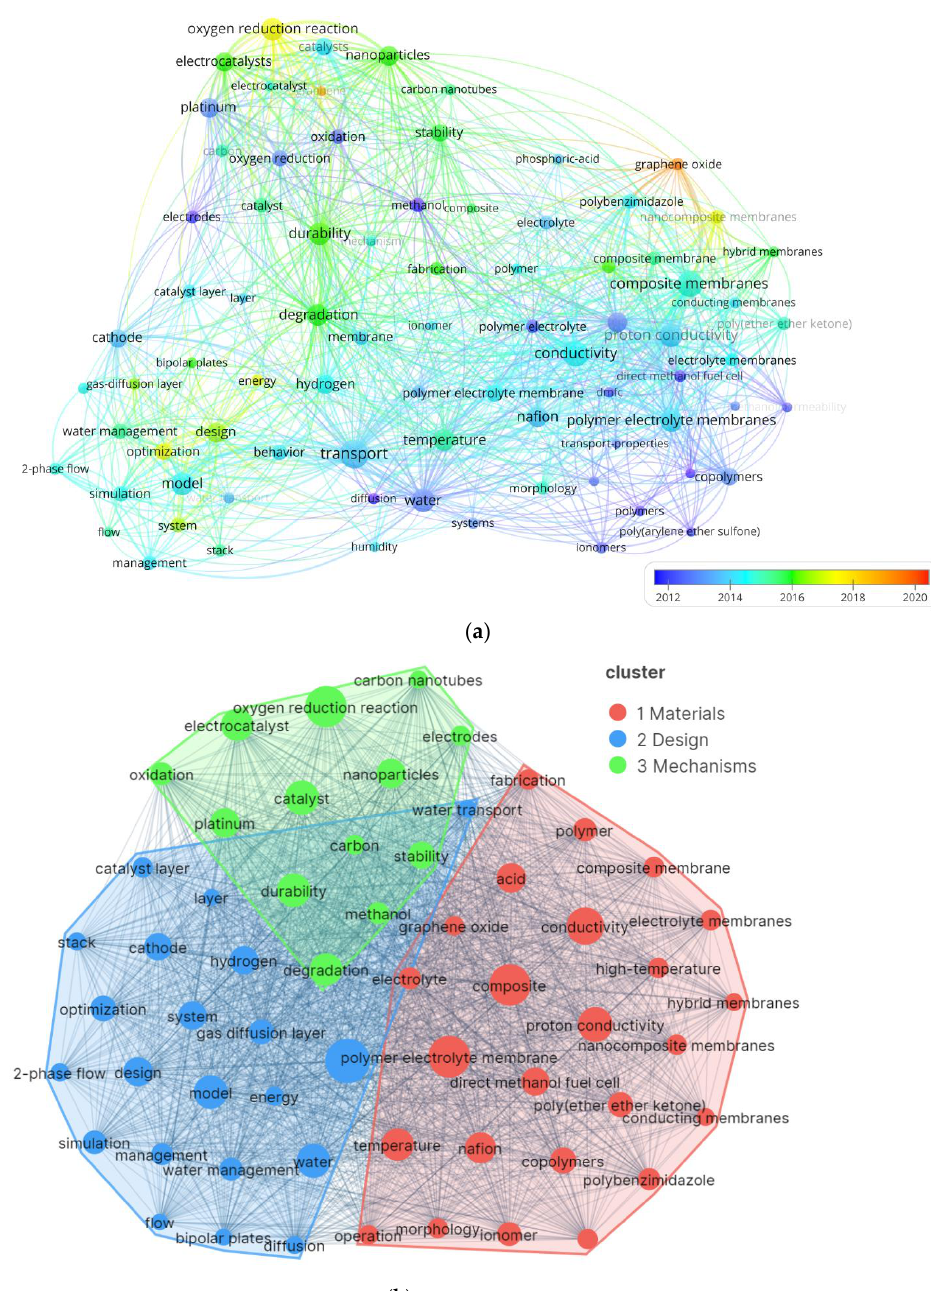
Figure 9. Keywords maps of PEMFC research ( a ) the overlay map of keywords ( b ) the keywords map in the distribution plot of three clusters.